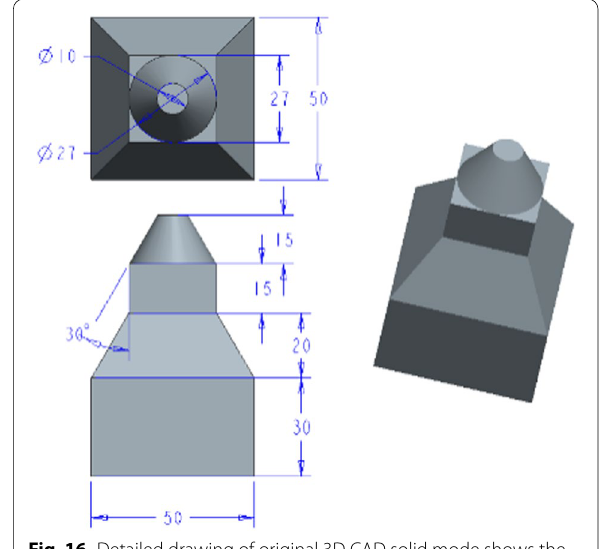
Fig. 16 Detailed drawing of original 3D CAD solid mode shows the CAD for a regular shape in solid modeling representation, designed using PTC Creo Parametric CAD software as case study no. 1